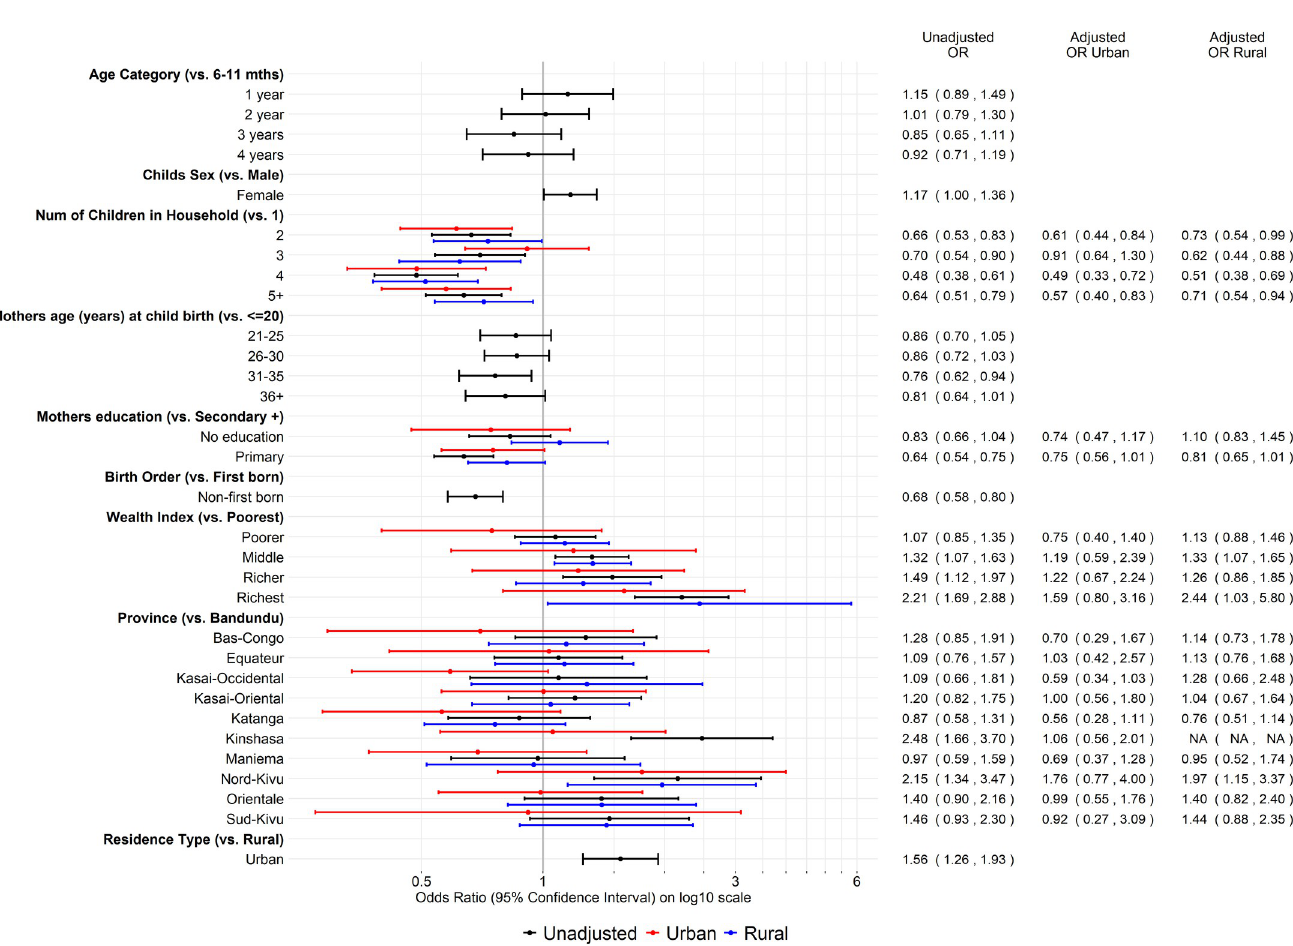
Fig 5. Odds ratios of tetanus seroprotection. Forest plot of odds ratios from weighted logistic regression of sociodemographic factors/characteristics associated with tetanus seroprotection among children 6–59 months old in the EDS-RDC II, unadjusted and stratified by residence type (adjusted for all other variables in the